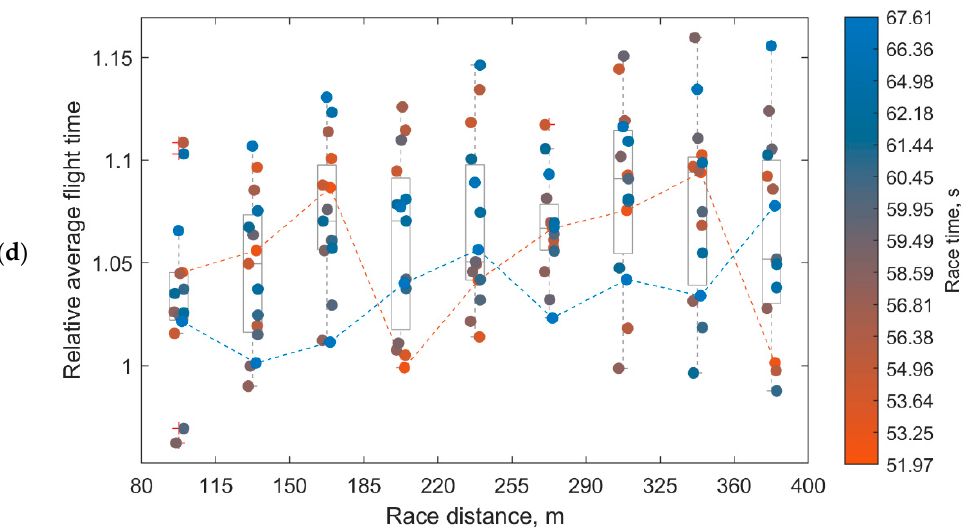
Figure 8. Evolution of AvSPE ( a ), AvCT ( b ), AvSTF ( c ), and AvFLY ( d ) between the third and the last interval. The y-axis values are expressed relative to the average values obtained within the second interval (45 to 80 m). The orange to blue gradient is used to differentiate the athletes according to their performance time, with the boundary performances (slowest and fastest athlete) being illustrated with dashed lines. For better visibility of individual data points, a small scatter was introduced in the x-direction.